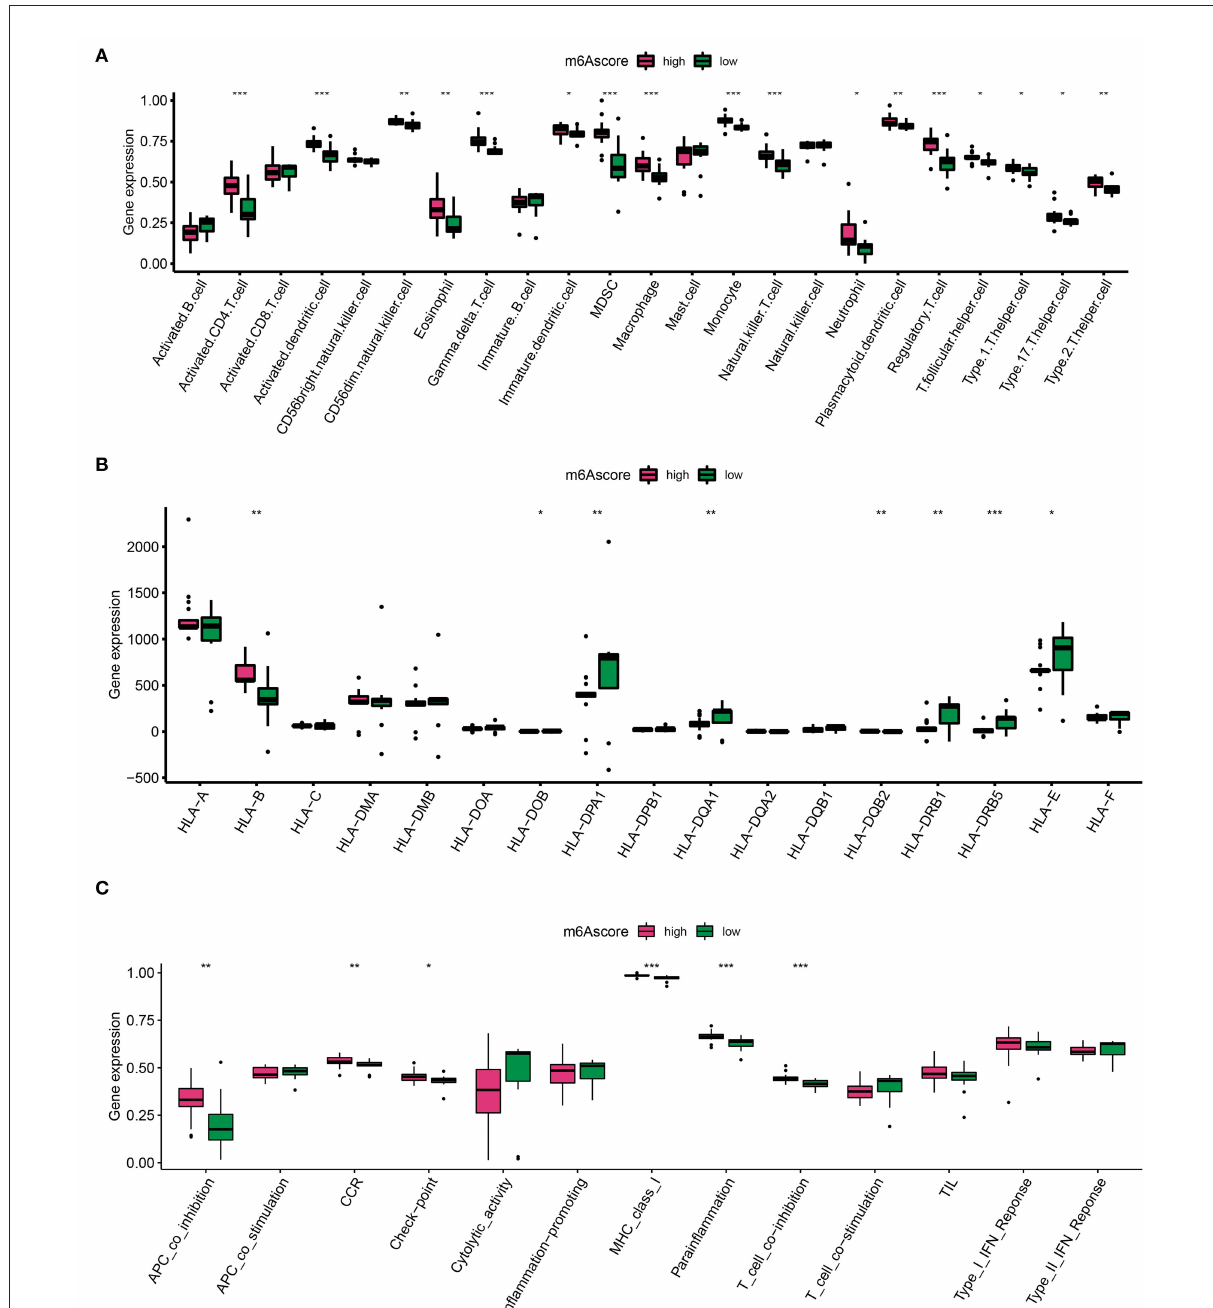
FIGURE6 Diversity of IME characteristics of high and low m6A score groups. (A) The immune cell infiltration status in high and low m6A score groups. (B) The expression landscape of HLA family genes in high and low m6A score groups. (C) The evaluation of immune response gene set in high and low m6A score groups. * p < 0.05, ** p < 0.01, *** p < 0.001 indicated the statistical significance of